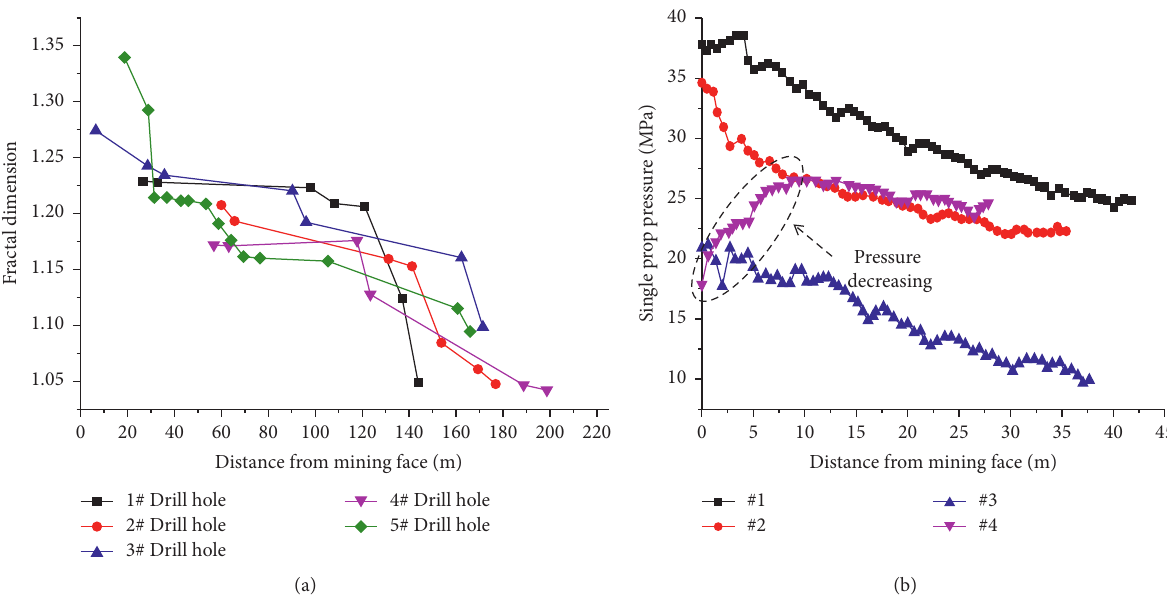
Figure 8: Field observations collected by Gao et al. [13]: (a) schematic diagram of the evolution of fractal dimension in different drill holes with distance from the mining face; (b) evolution of the pressure on a single prop as the mining face advances.